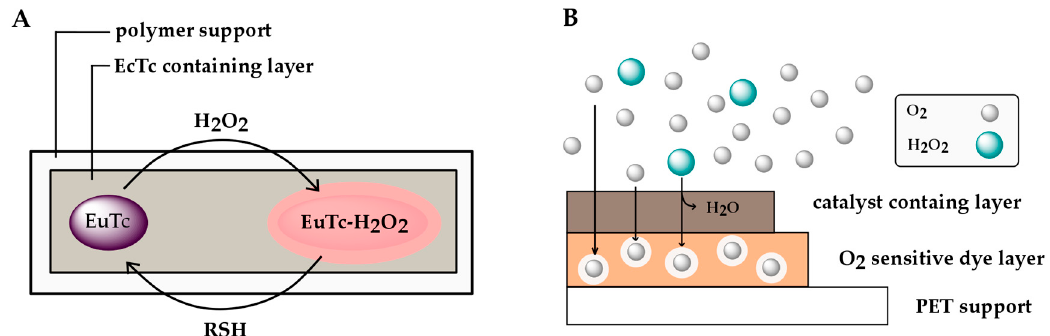
Figure 7. Principle for quasi-reversible luminescence based detection of H 2 O 2 . ( A ) Reversible H 2 O 2 sensor, based on the coordination of H 2 O 2 to EuTc resulting in a strongly fluorescent complex. The reaction can be reversed by adding thiols; ( B ) Schematic depiction showing indirect H 2 O 2 sensing via O 2 measurements. Hydrogen peroxide (blue) is degraded in the catalyst-containing layer into water and O 2 ; which then is detected via fluorescence quenching (white ring around the O 2 ) of an indicator dye, together with background O 2 (gray).